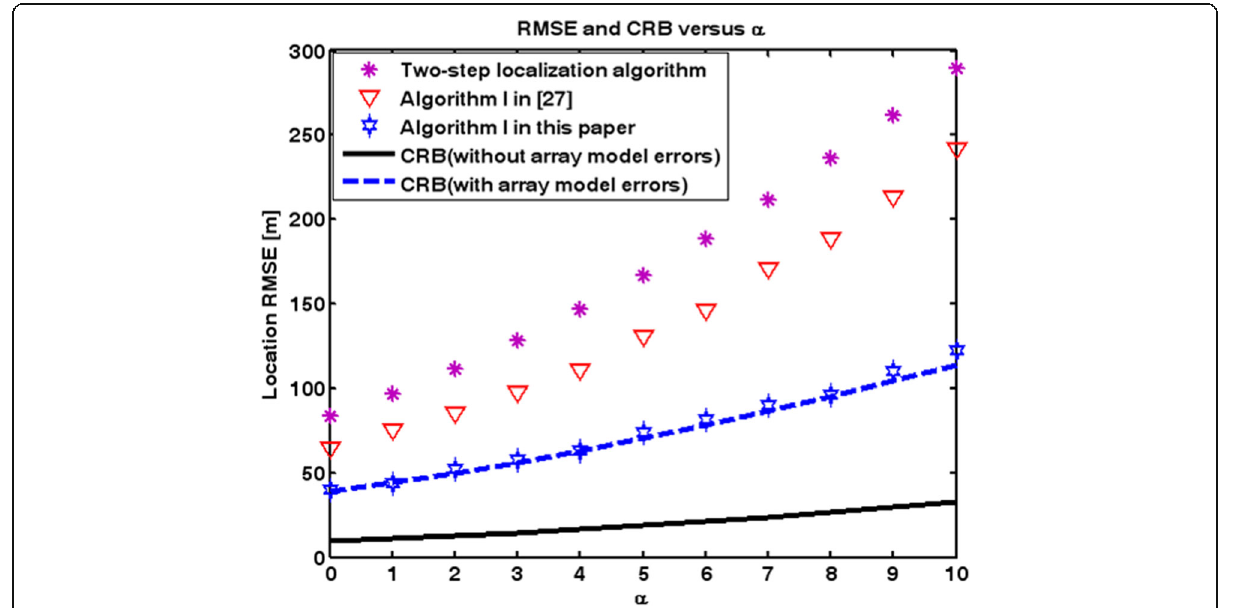
Fig. 6 RMSEs of localization methods and the corresponding CRBs as a function of α for case of unknown signal